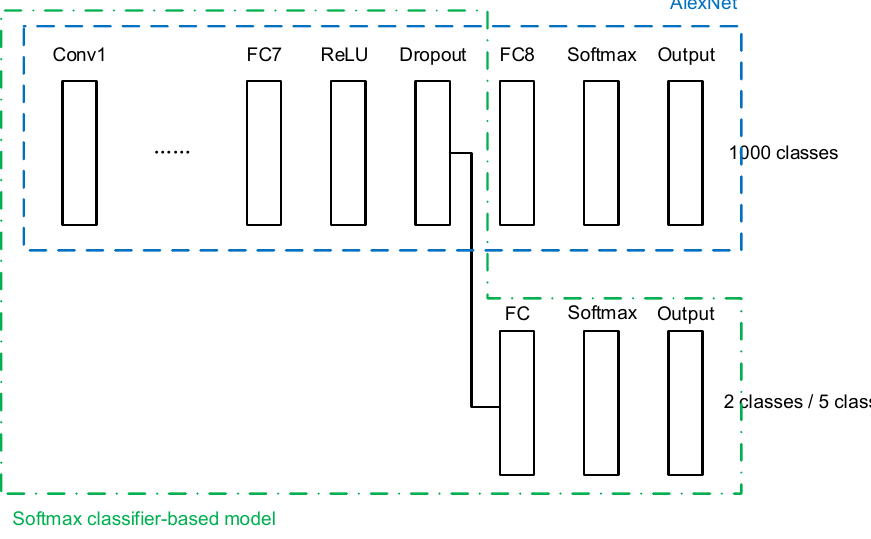
Figure 4. Softmax classifier-based model.